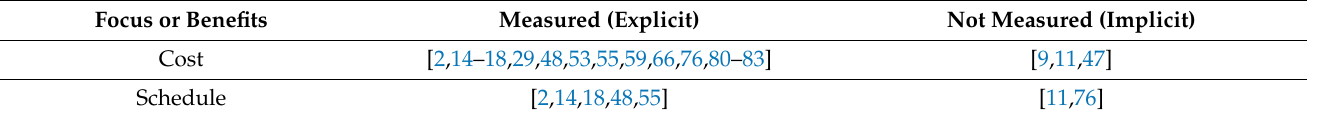
Table 2. Explicit and implicit benefits on TVD